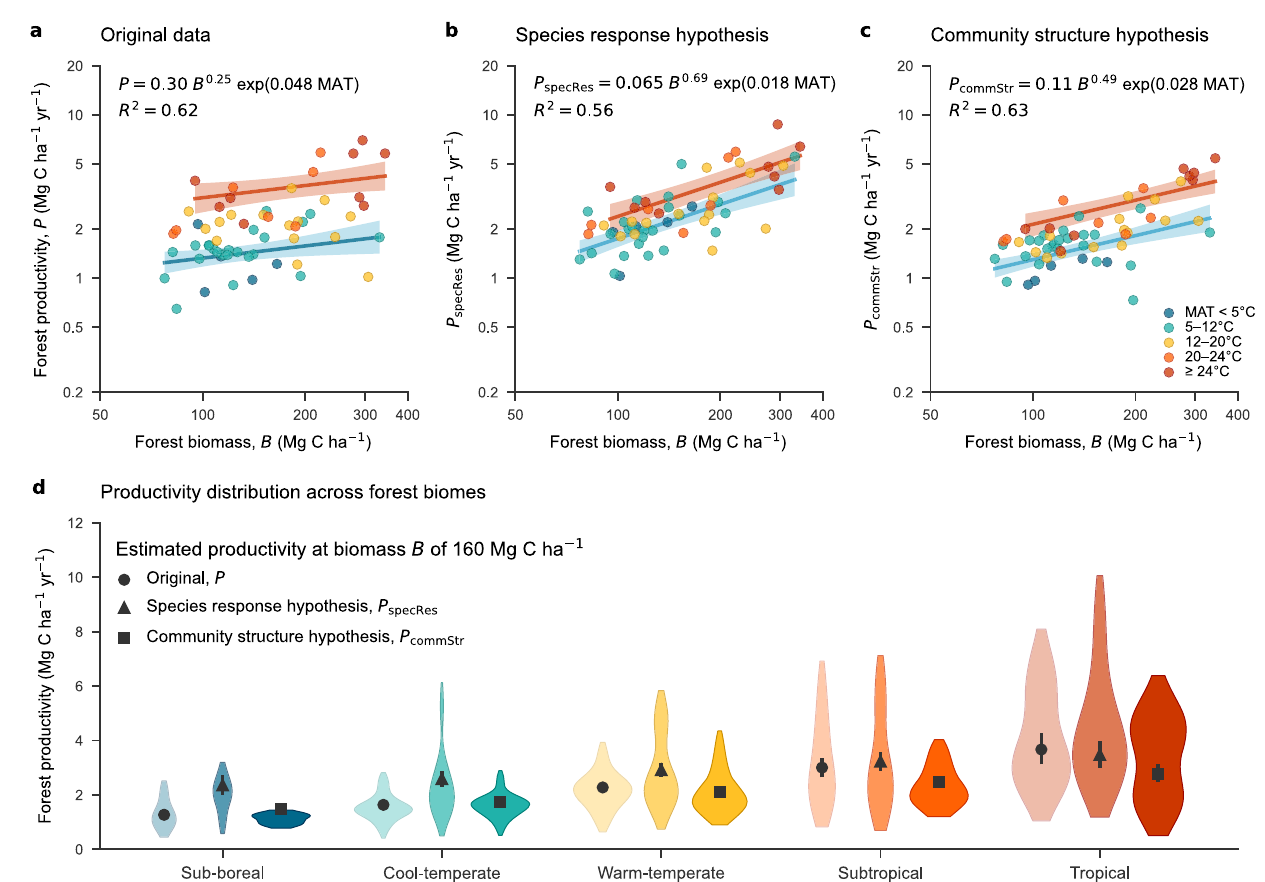
Fig. 4 | Estimated forest-level woody productivity in relation to standing bio- productivity is resampled from a species population with similar biomass drawn mass and temperature among 60 plots in eastern Asia. a Forest-level above- from all the plots. In a – c , regression lines indicate mean with 95% con fi dence intervalsareshownfortropical( ≥ 24°C,redline)versuscool-temperate/sub-boreal groundwoodyproductivityestimatedfromoriginaldata P (i.e.,estimatesbasedon forests(<12°C,blueline)predictedbypower-lawmodels.Estimatesandcoef fi cient constituent species productivity) against forest aboveground biomass per area. b Estimated woody productivity representing the species response hypothesis, of determination for the power-law model are shown in each panel. d Forest-level P P woody productivity distribution in fi ve biomes grouped by mean annual tem- specRes , against forest biomass; specRes is obtained assuming that all species perature (MAT): coloured areas show the distribution of woody productivity with populations across 60 plots respond to the species productivity-biomass power- kernel density estimation; inside symbols with bars are mean and 95% con fi dence law speci fi c to each plot of interest, and that frequency distribution of species intervals of predicted productivity at the forest biomass of 160MgCha – 1 (mean biomass of the plot is the same as the distribution of all species populations of all across 60 plots). Source data are provided as a Source Data fi plots. c Estimated woody productivity representing the community structure hypothesis, P commStr , against forest biomass, where inferred species woody